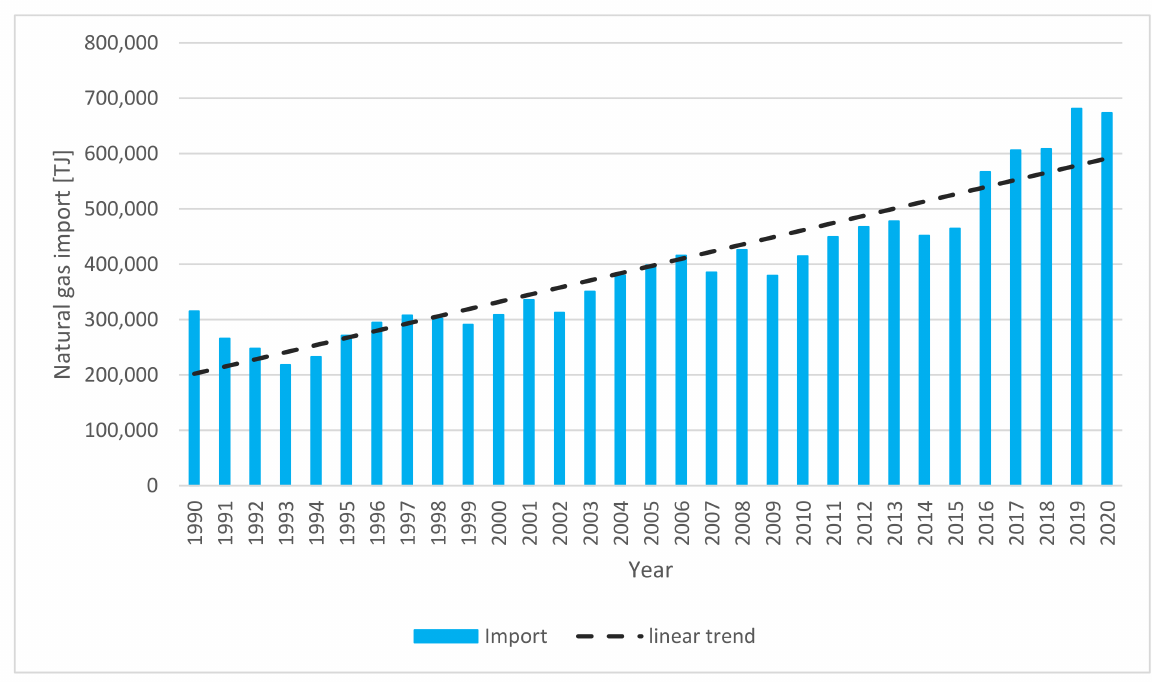
Figure 2. Natural gas import in the years 1990–2020, own study based